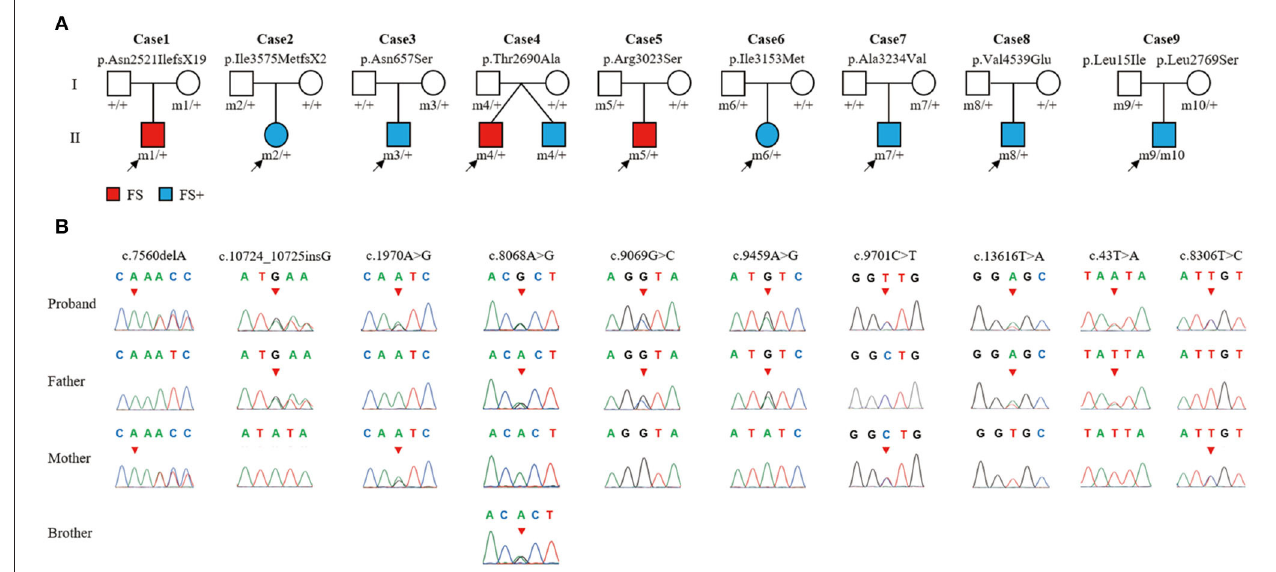
FIGURE 1 | The ADGRV1 variants identified in the nine cases of febrile seizures or epilepsy with antecedent febrile seizures. (A) Pedigrees of the nine cases with ADGRV1 variants and their corresponding phenotypes. (B) DNA sequence chromatograms of the ADGRV1 variants. Arrows indicate the positions of the nucleotide